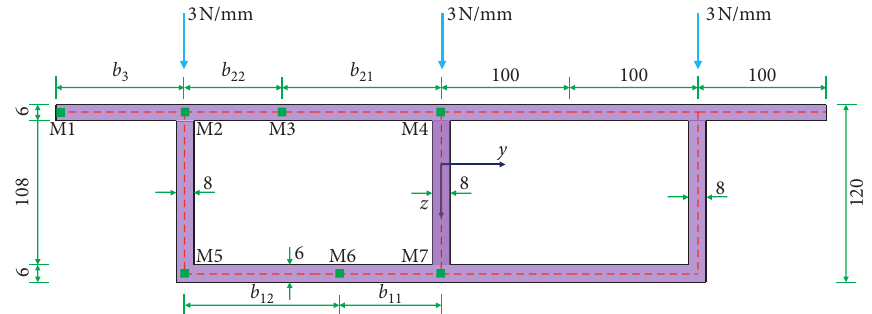
Figure 7: Cross section of the single-box two-cell box girder (unit: